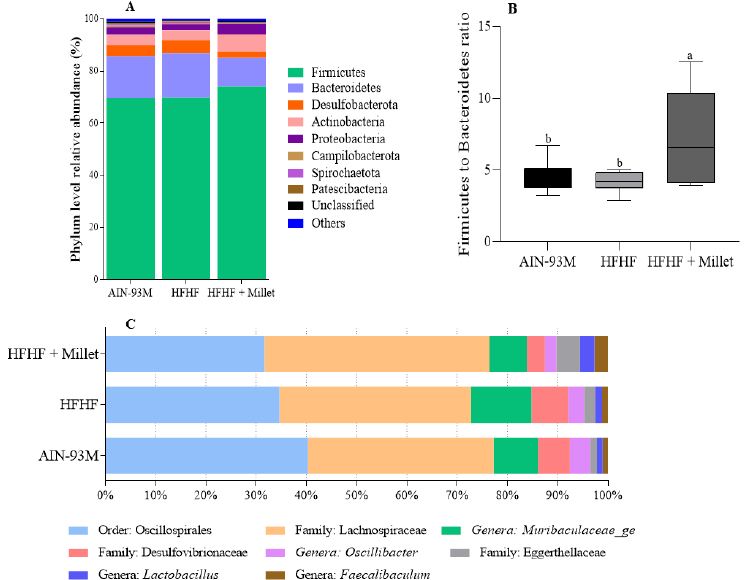
Figure 4. Compositional changes in intestinal microbiota in response to a germinated millet flour diet after 10 weeks. ( A ): Relative abundance of phylum; ( B ): Firmicutes/Bacteroidetes ratio; ( C ): Taxonomy level changes in each experimental group. Columns with different letters indicate sig- nificant differences by one-way ANOVA and post hoc of Newman–Keuls test ( p < 0.05). The top line of the box represents the upper bound of the data, the bottom line indicates the lower bound, and the middle of the box represents the median. n = 10/group (AIN-93M, HFHF groups) and n = 9/group (HFHF + millet group). AIN-93M: standard diet; HFHF: high-fat high-fructose diet; HFHF + millet: HFHF diet + 28.63% of germinated millet flour. Only phyla with abundance > 0.3% in at least one group were displayed.